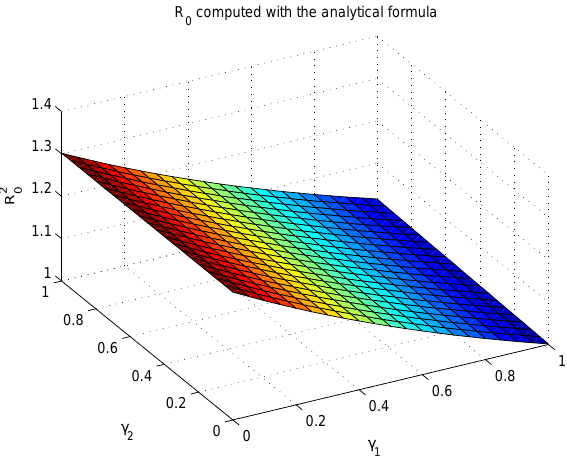
Fig. 7. Simulation of the evolution of the infected population per week for different values of γ .